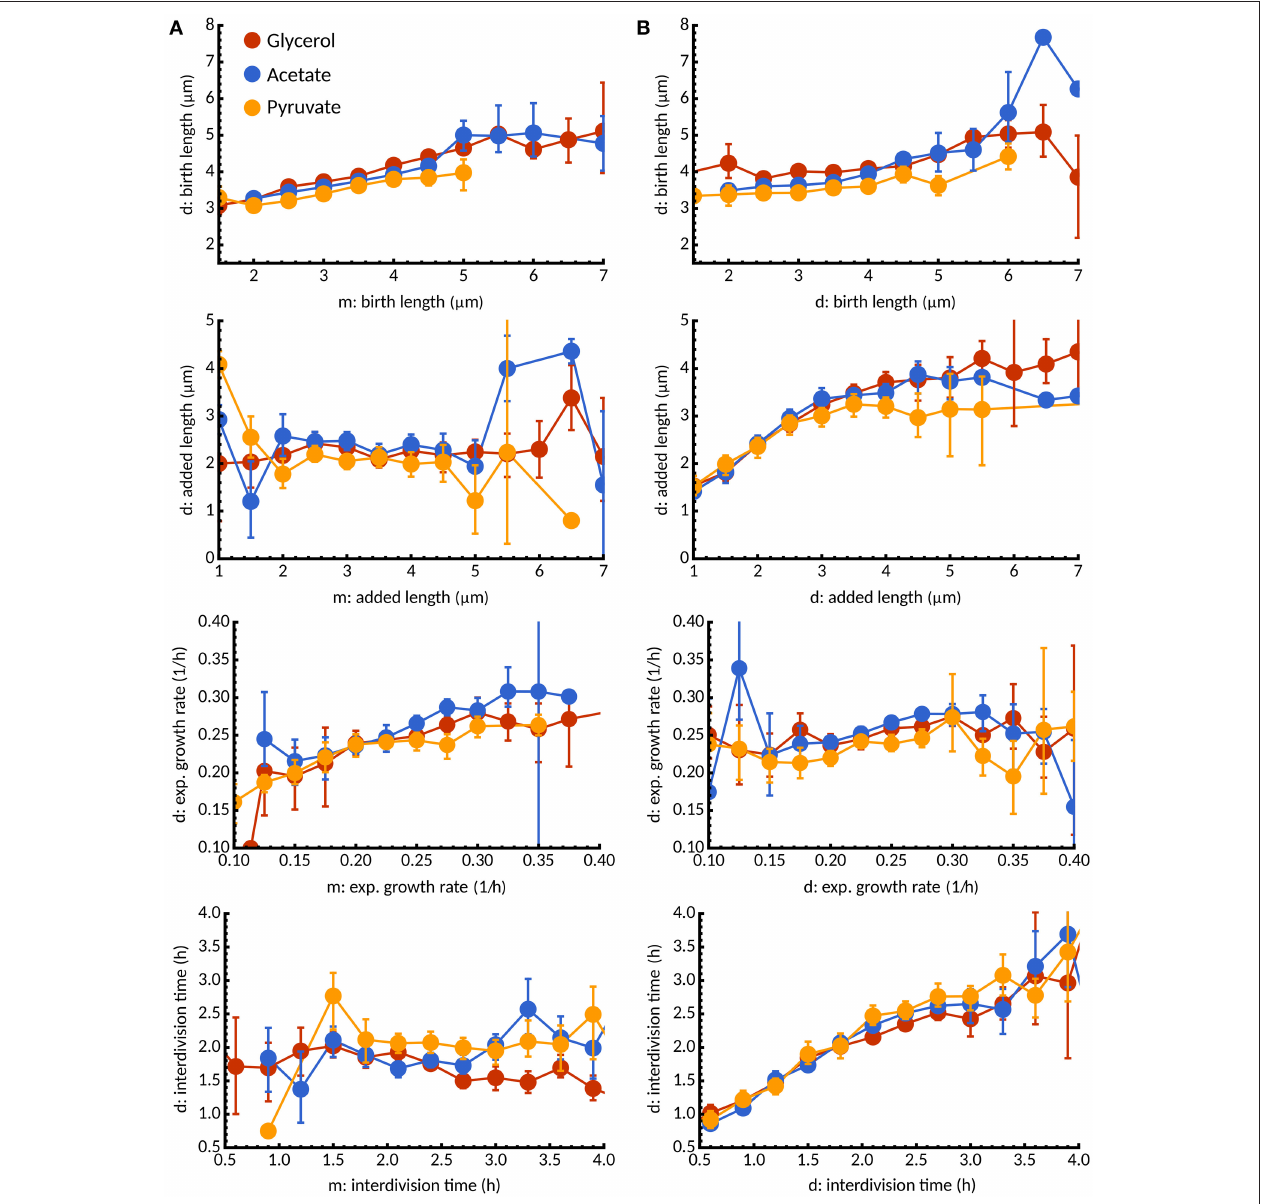
FIGURE 8 | Inheritance of growth parameters under different carbon sources. (A) Conditional expectation of birth length, added length, exponential growth rate, and interdivision time for daughter cells (d) as a function of the corresponding growth parameter in the mother cell (m). Colors indicate different carbon sources: glycerol (red), acetate (blue), pyruvate (yellow). For all media, we observe a statistical dependence between birth lengths in mother and daughter cells consistent with the adder principle but no inheritance between added lengths. Interestingly, growth rate is inherited but not interdivision time. (B) In contrast, between sister cells added length and interdivision times are statistically dependent but not growth rate and interdivision